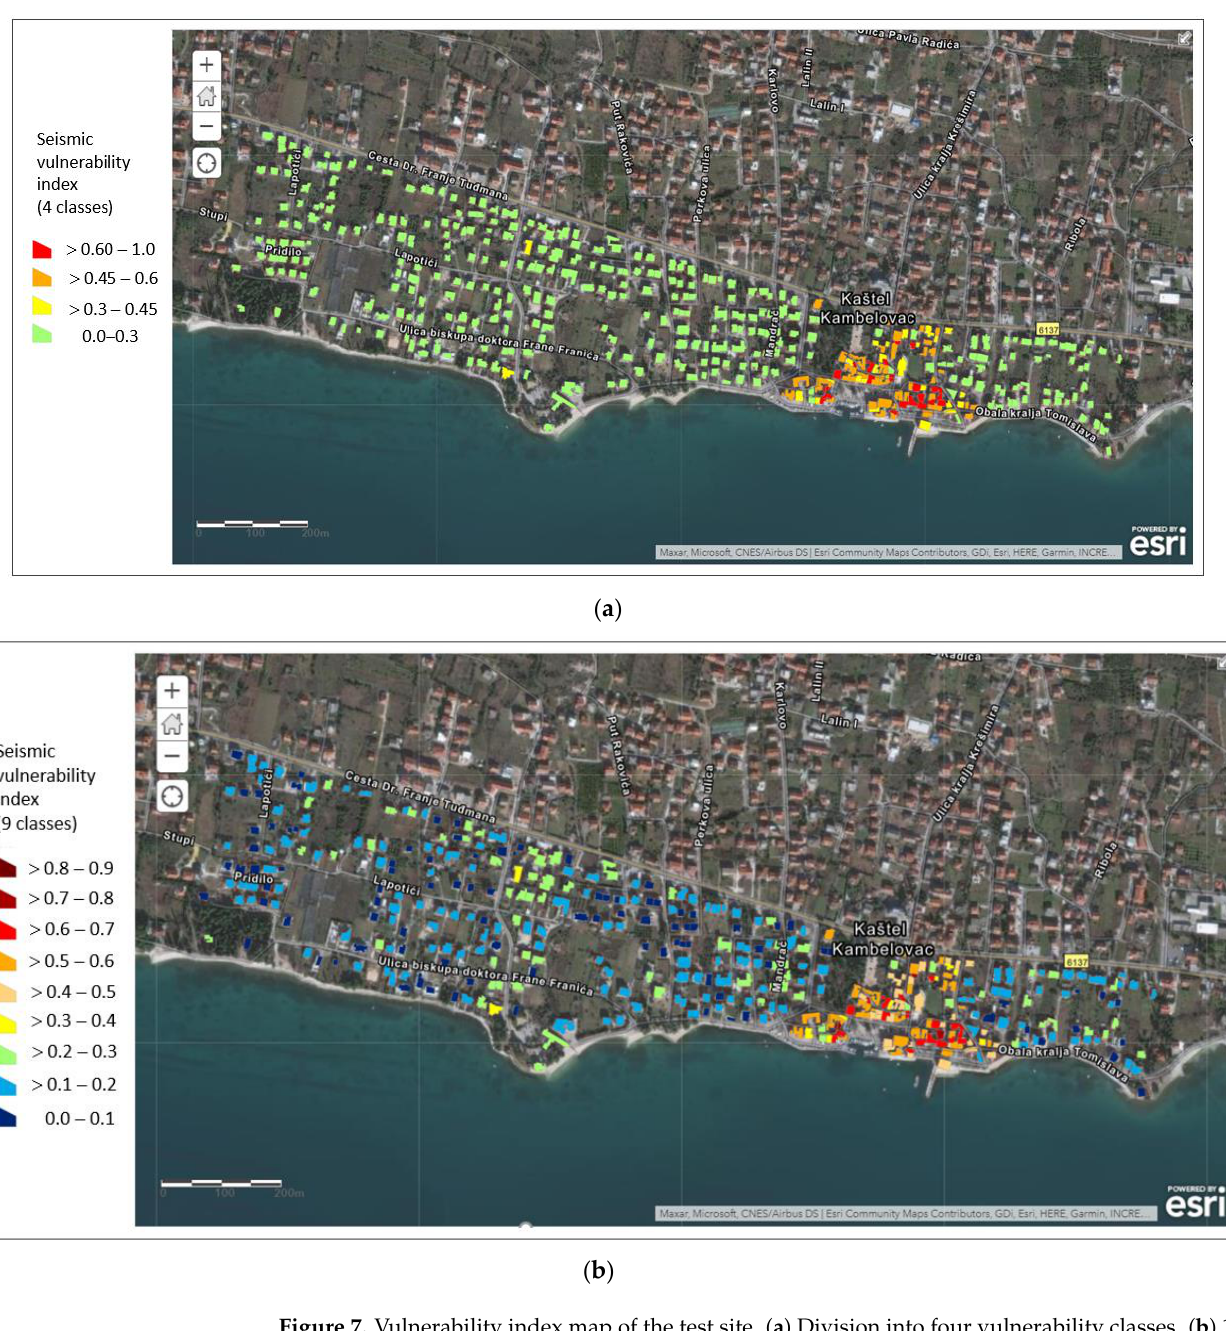
Figure 7. Vulnerability index map of the test site. ( a ) Division into four vulnerability classes. ( b ) 10% division intervals.